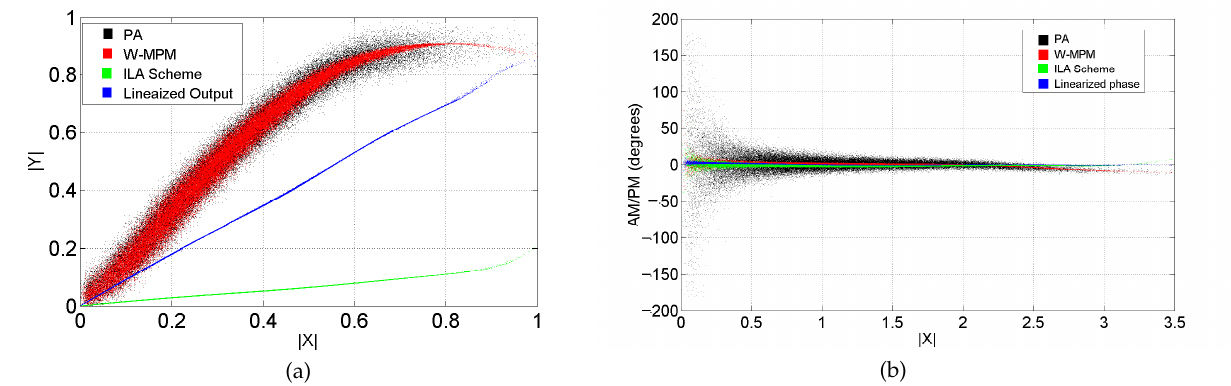
Figure 4. Linearization based on ILA based on W-MPM for the device NXP 10 W at 2.34 GHz. ( a ) AM/AM modeling and linearization stage and ( b ) AM/PM modeling and linearization stage.